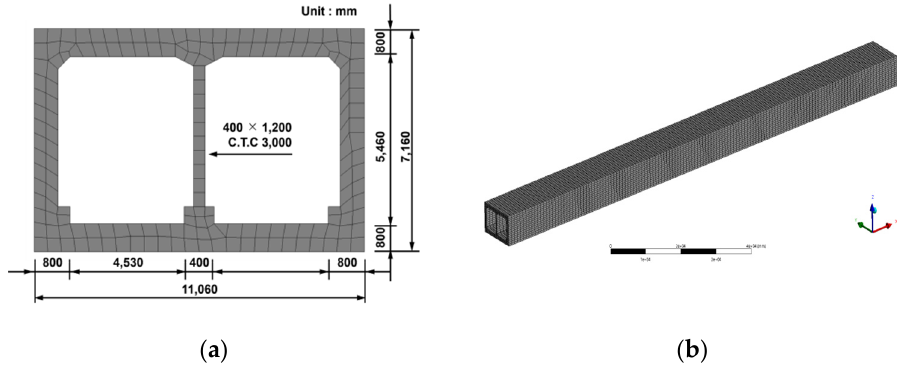
Figure 6. 3D modeling mesh: ( a ) front view; ( b ) 3D view.